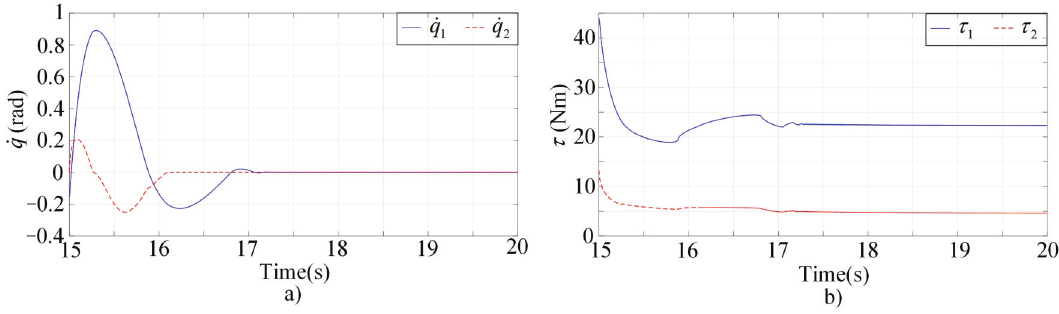
Figure 3. Simulation results of the multimodal controller in t ∈ [ 8,15 ) . ( a ) The tracking errors; ( b ) The control inputs.